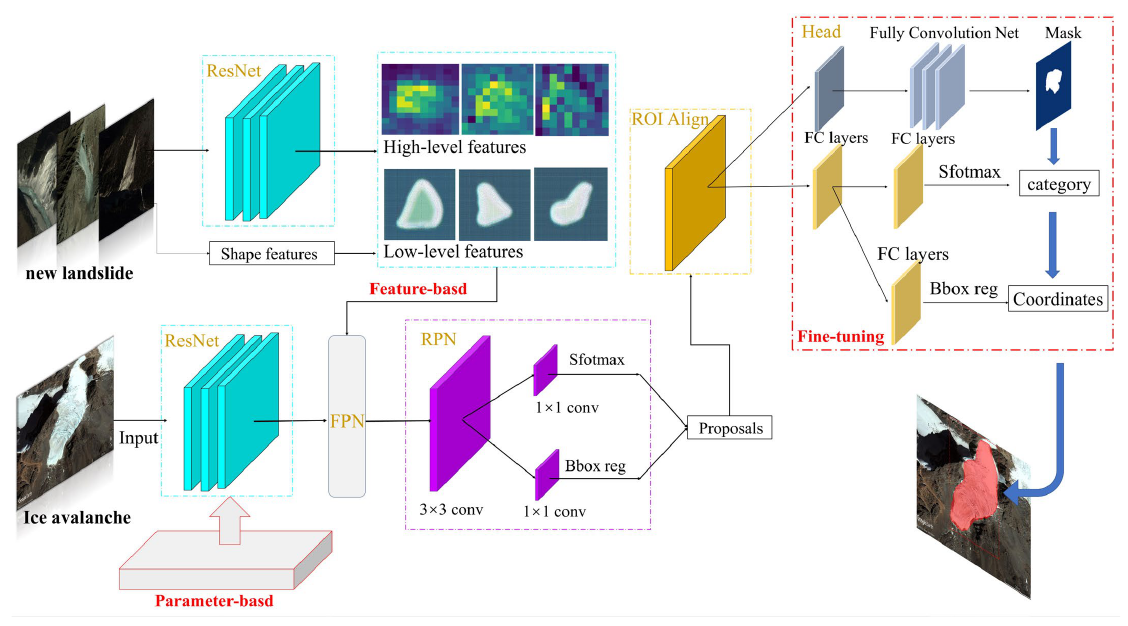
Figure 9. Architecture of the TL- Mask R-CNN.